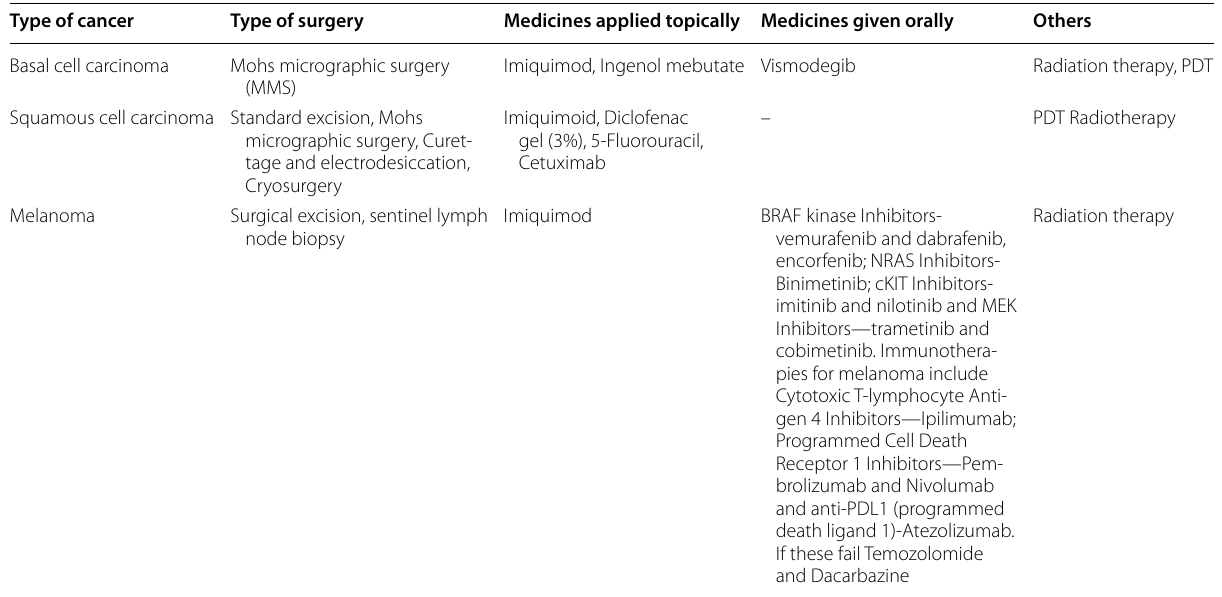
Table 1 Management of skin cancer Type of cancer Type of